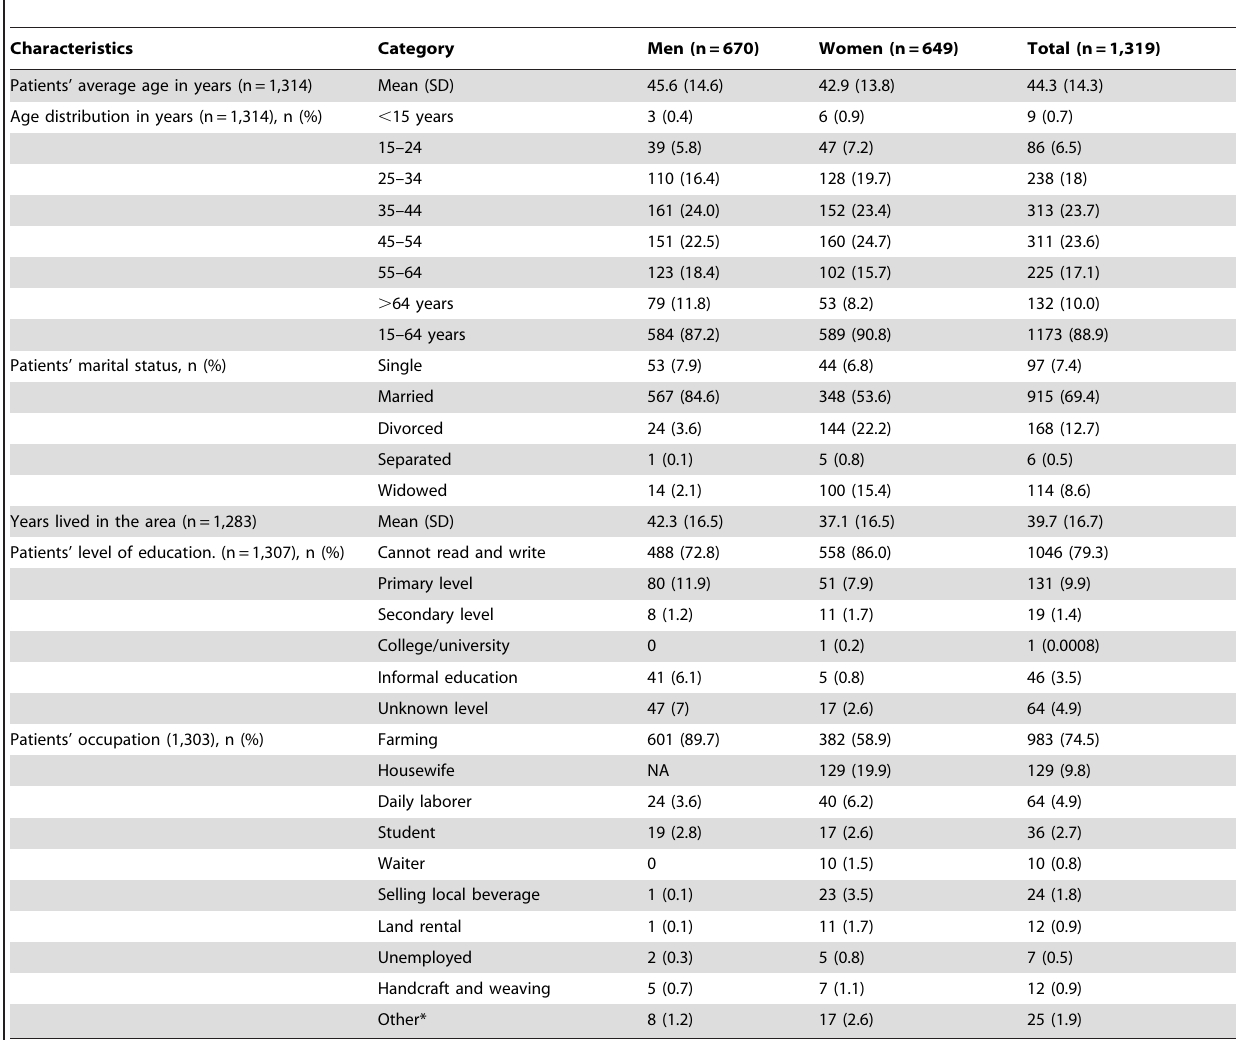
Table 1. Characteristics of interviewed patients (n= 1,319), Debre Eliyas and Dembecha Woredas , East and West Gojam Zones, northern Ethiopia.